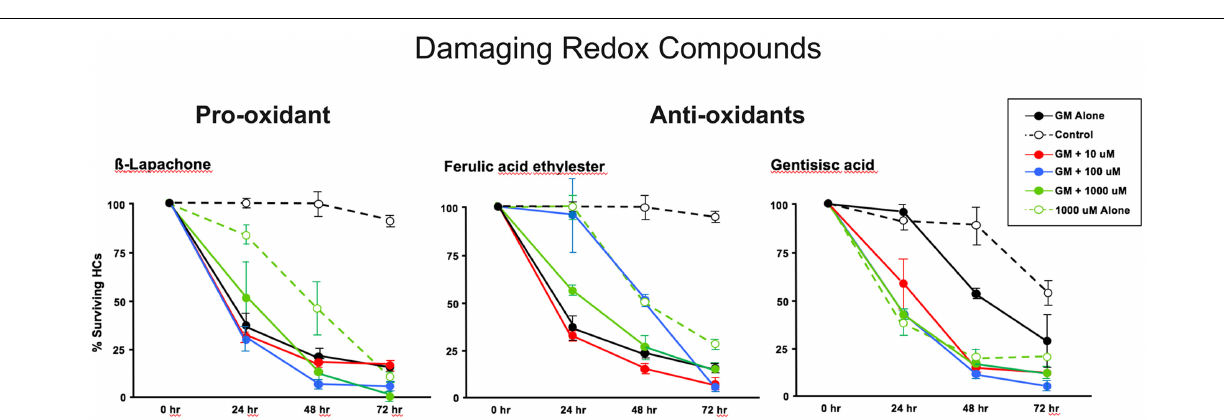
FIGURE 7 | Normalized D1–4 HC survival curves for 1 pro-oxidant ( β -lapachone) and 2 representative antioxidants (ferulic acid ethylester and gentisisc acid). When each of these compounds was applied to micro-explants in the absence of concurrent gentamicin, far more HC damage was observed than in untreated (negative controls) micro-explants. N = 6 micro-explants/data